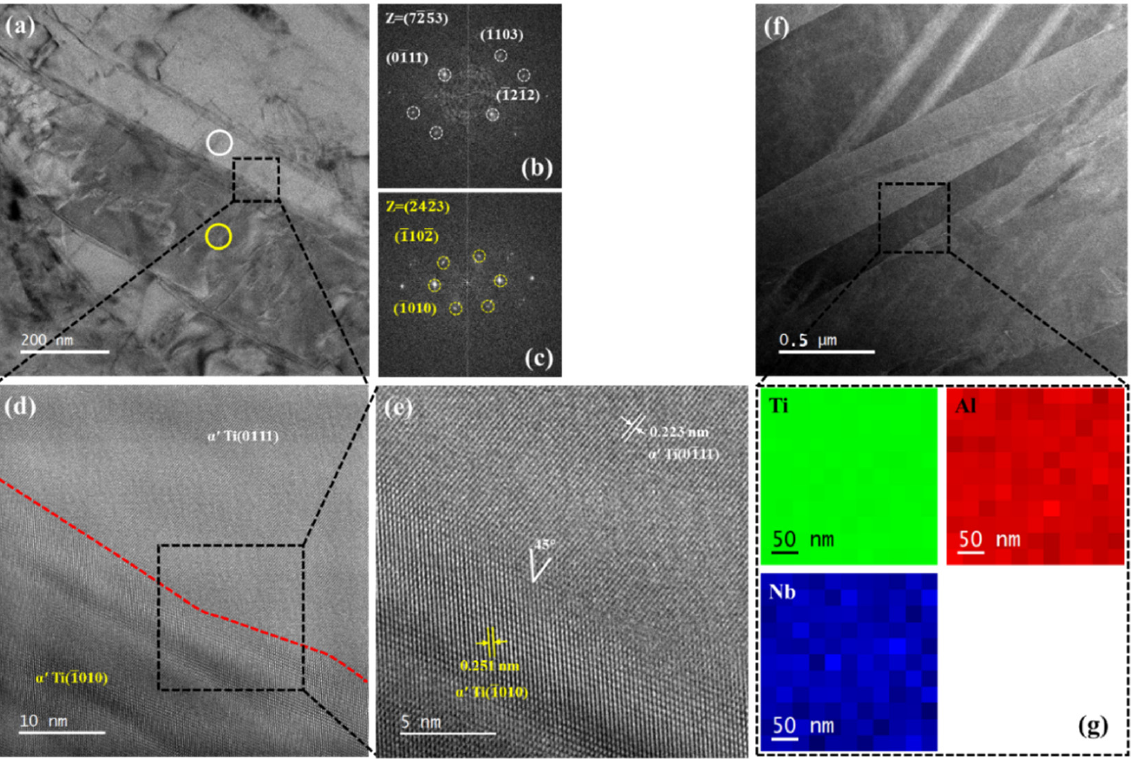
Figure 4. ( a ) TEM image of the as-built sample; ( b , c ) FFT pattern taken from the white and yellow circular areas in ( a ); ( d ) HRTEM image of the black square region in ( a ), the red line shows the boundary between two α′ -martensite laths; ( e ) HRTEM image of the black square region in ( d ); ( f ) HAADF-STEM image of the as-built sample; ( g ) EDS maps of the black square region in ( f ).